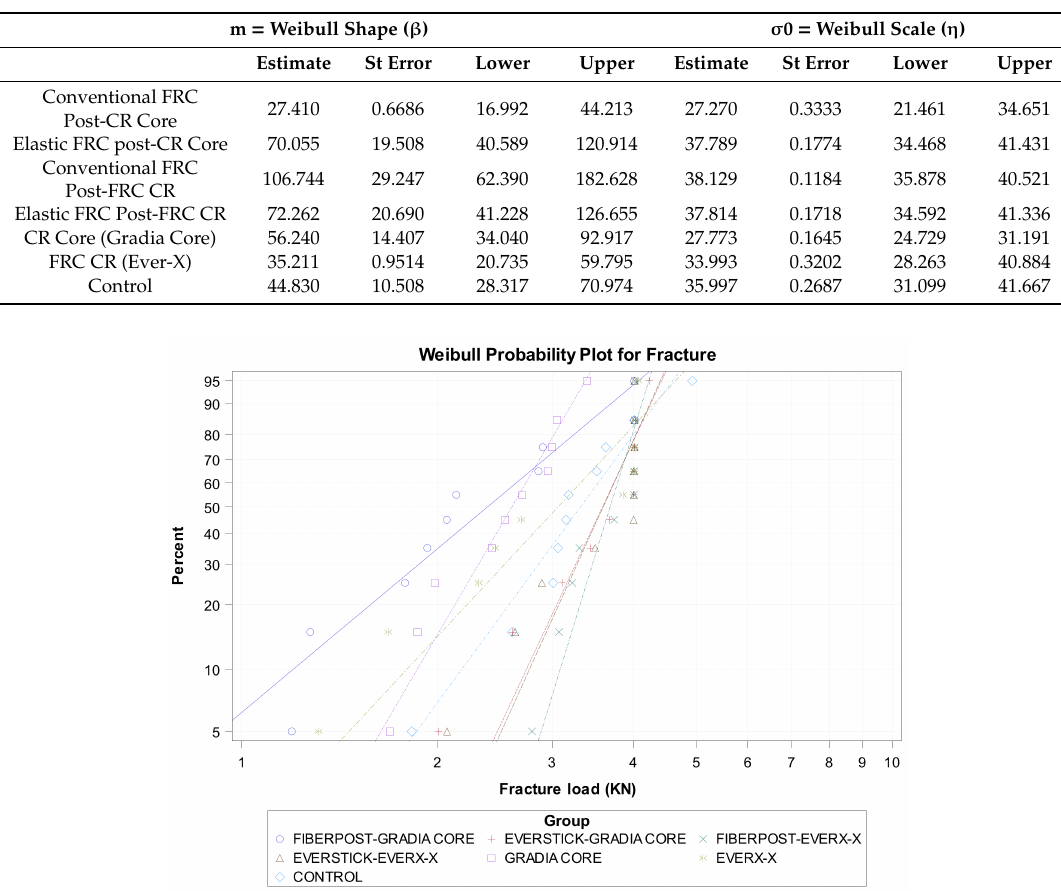
Table 4. Weibull statistics of the fracture resistance of the study groups after bending test.